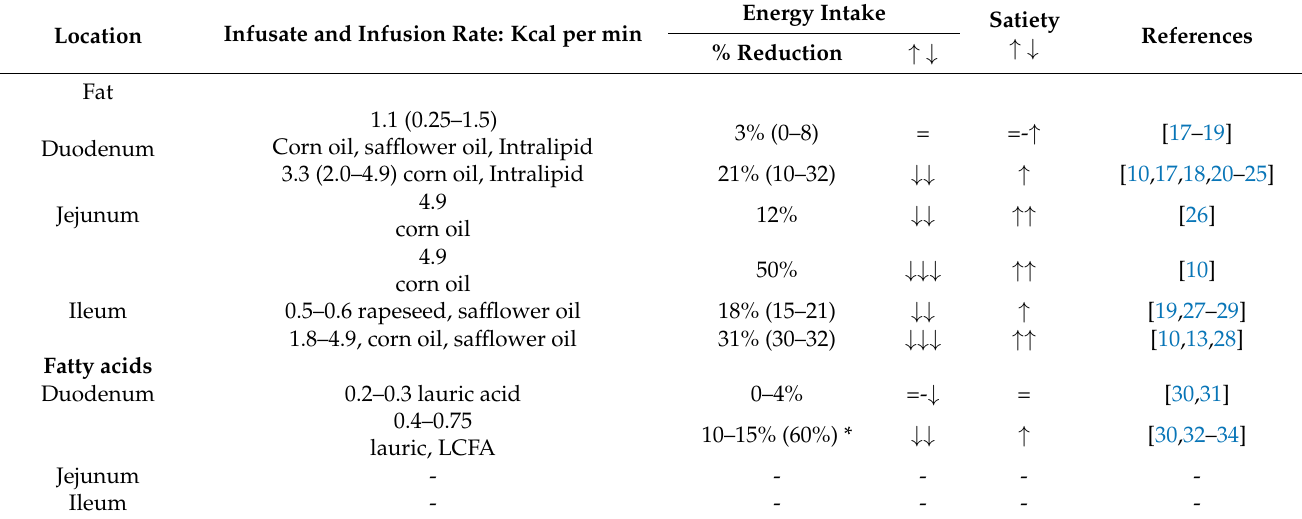
Table 1. Effect of infusion of fat or fatty acids into duodenum, jejunum or ileum on energy intake and satiety. Location